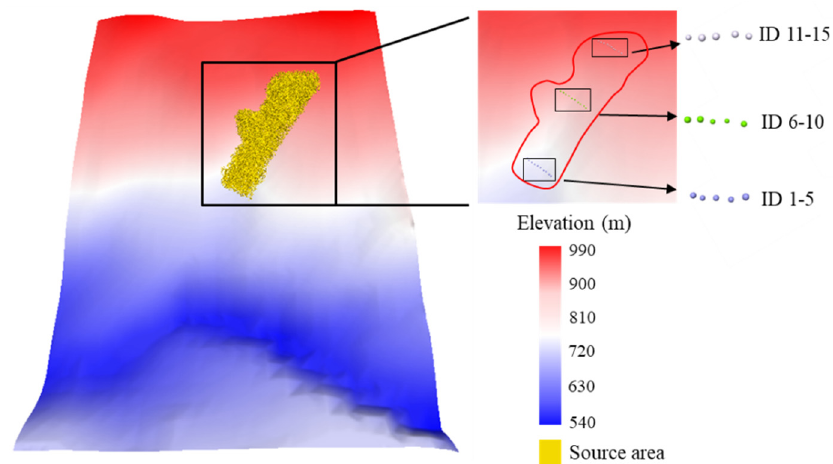
Figure 10. PFC model of the Shaziba landslide with monitored particles.